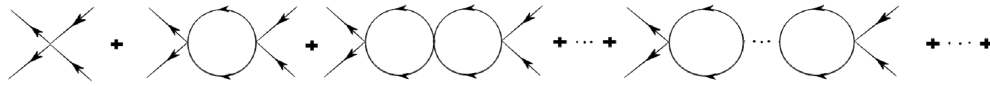
Figure 5. A diagrammatic representation of the sum of geometric series of concatenated two-point loop diagrams (Dyson’s equation); this sum produces the self-consistent equation for the full